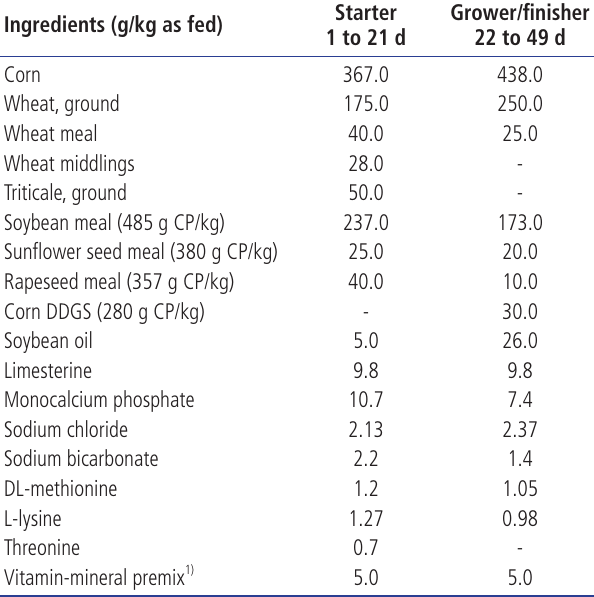
Table 2. Chemical composition of the diets for ducks Ingredients (g/kg as